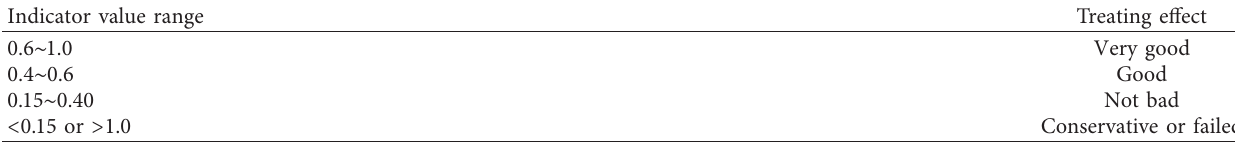
t ) with treating effect.